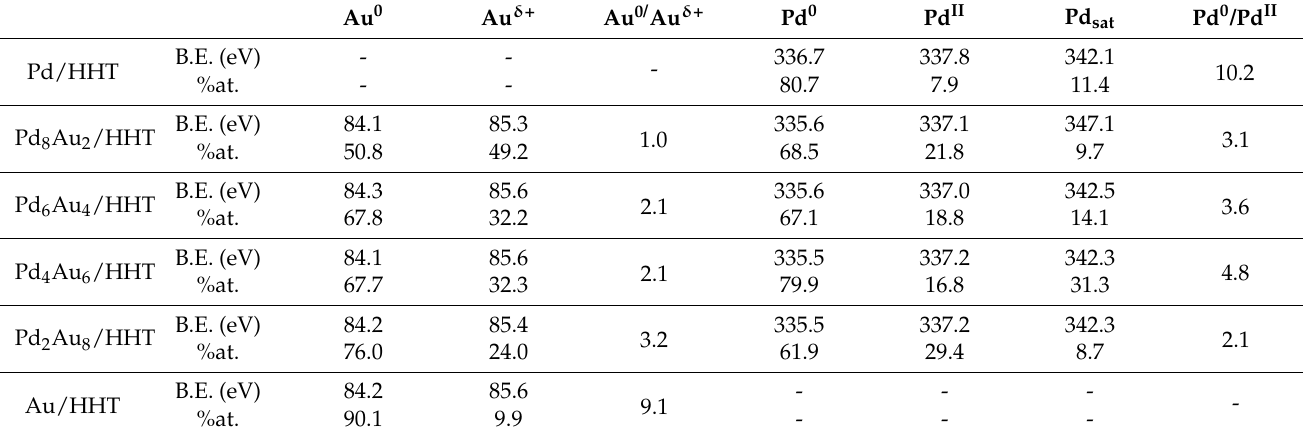
Table 3. Results of HR spectra of Au 4f and Pd 3d regions (chemcatchem, 2021, doi.org/10.1002/cctc.202100886, in